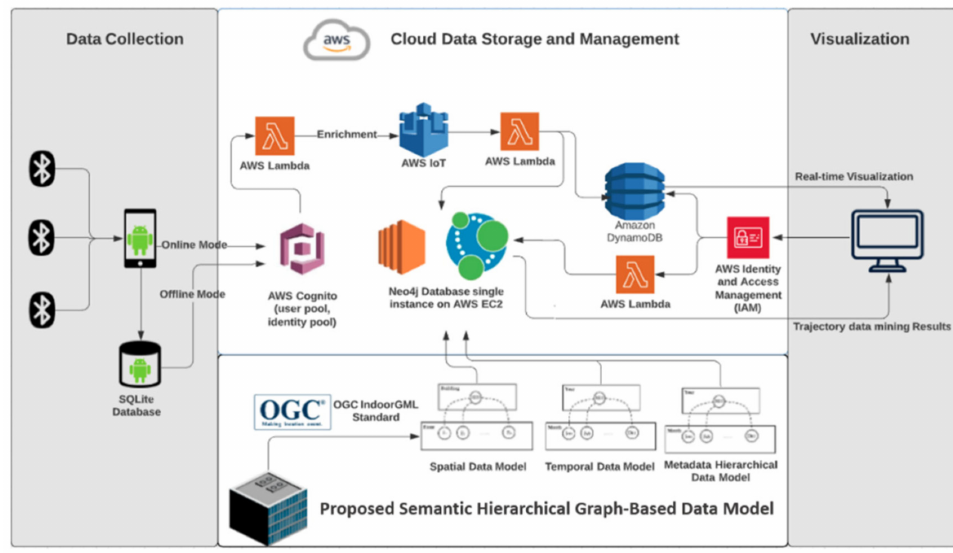
Figure 8. System